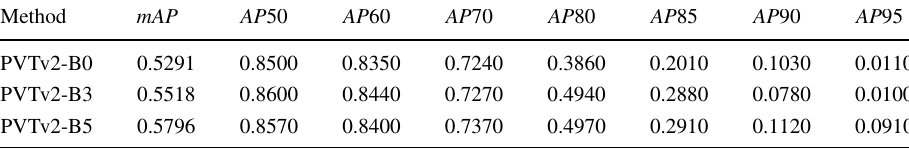
Table 5 Ablation experiments of HSV data augmentation on HRSC2016